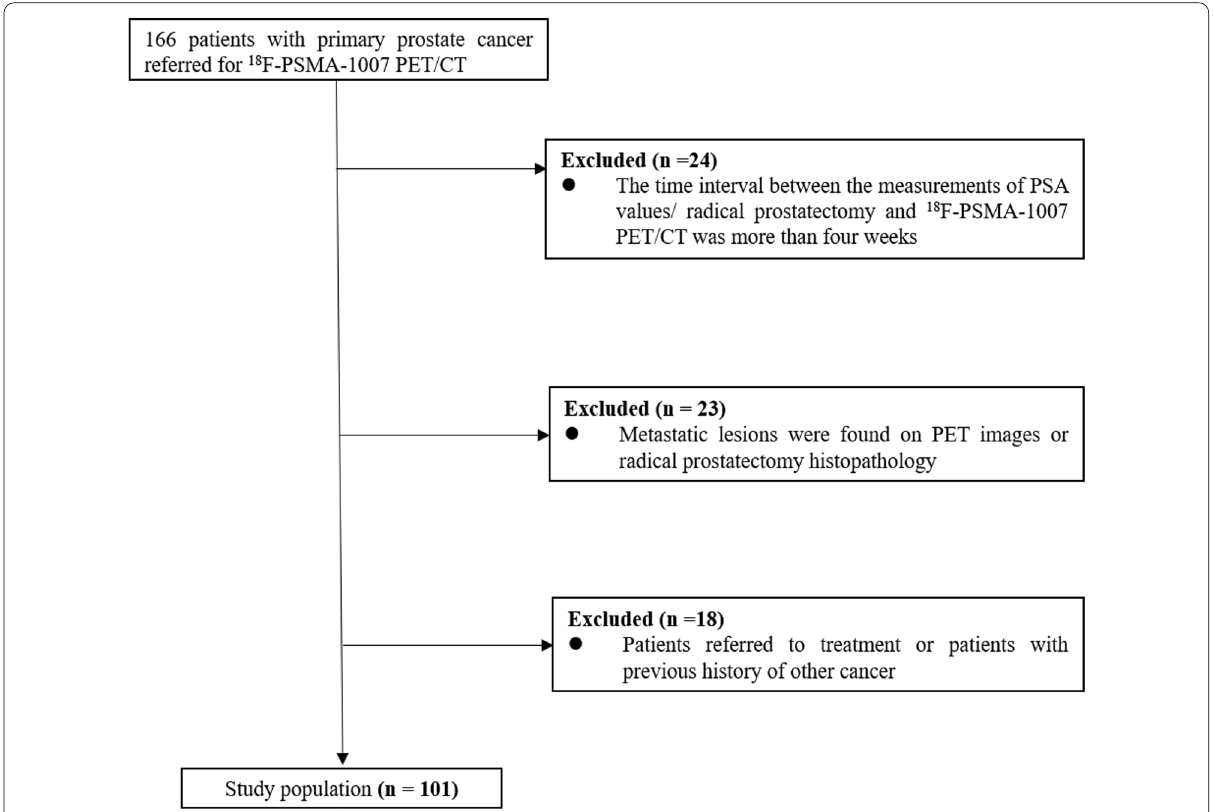
Fig. 1 Flowchart of patient